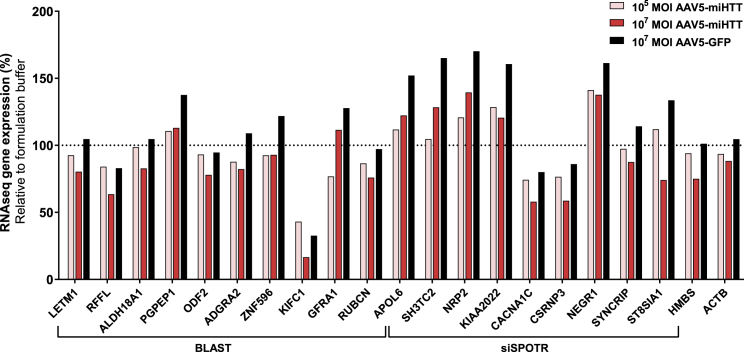
Confirmation of In Silico-Predicted AAV5-miHTT Target Genes from RNA-Seq AnalysisHD71 iPSC-derived neuronal cultures were transduced with AAV5-miHTT at a MOI of 105 or 107, formulation buffer as negative control, and AAV5-GFP at a MOI of 107 as viral transduction control (n = 4). RNA was isolated and unbiased RNA sequence analysis was performed. The analysis of the weighted proportions fold change and p value scores between the conditions were calculated using the Baggerley’s beta-binomial test. The housekeeping genes ACTB and HMBS are plotted in the graph to demonstrate equal RNA input between the treatment groups. Data were evaluated using a paired Student’s t test versus formulation buffer control.